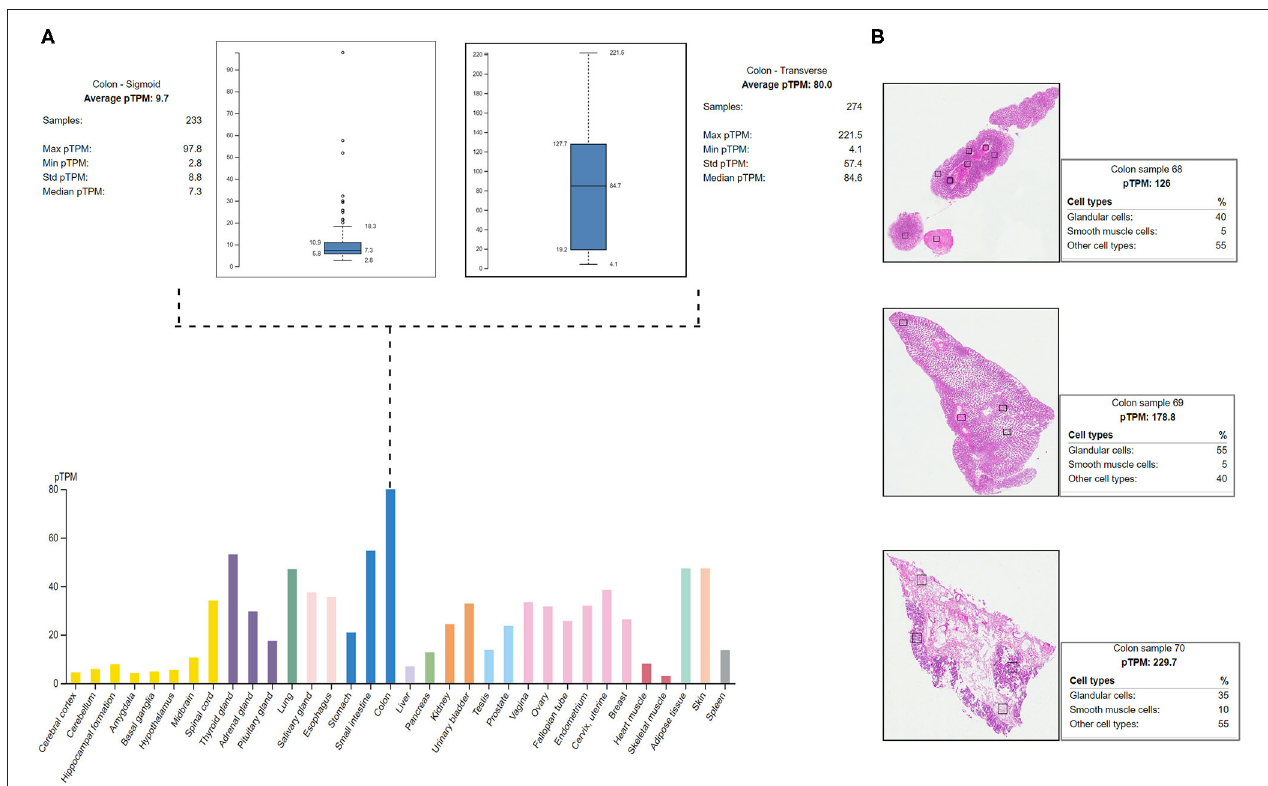
FIGURE 4 | Protein Atlas expression analysis of MYO1D . (A) Bar graph represents the MYO1D expression in sigmoid and transverse colon samples. (B) Histopathological examinations of colonic samples from three different patients showing the MYO1D protein expression.